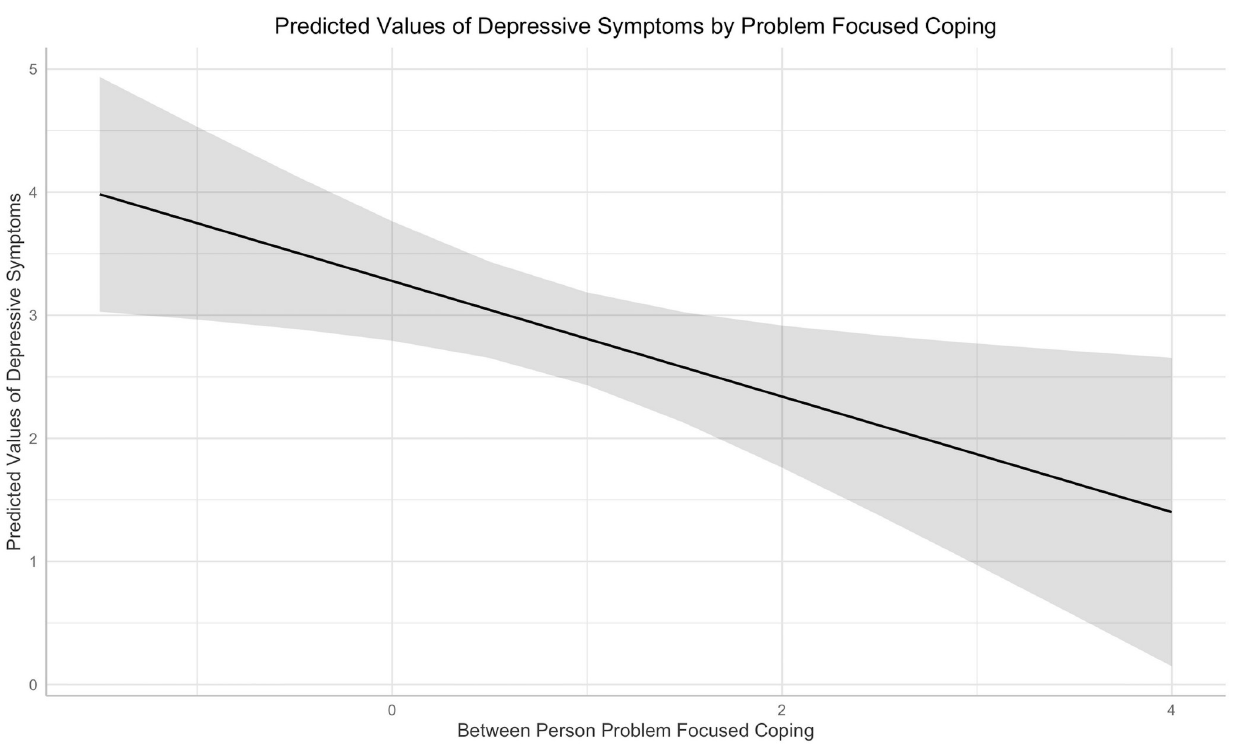
Fig 2. Predicted values of depressive symptoms across the range of between-person problem-focused coping ratings (x-axis). The grand mean centered coping variable, which ranged from -2 to 4, represents an individual’s relative position to the overall sample in their use of problem-focused coping over the course of the